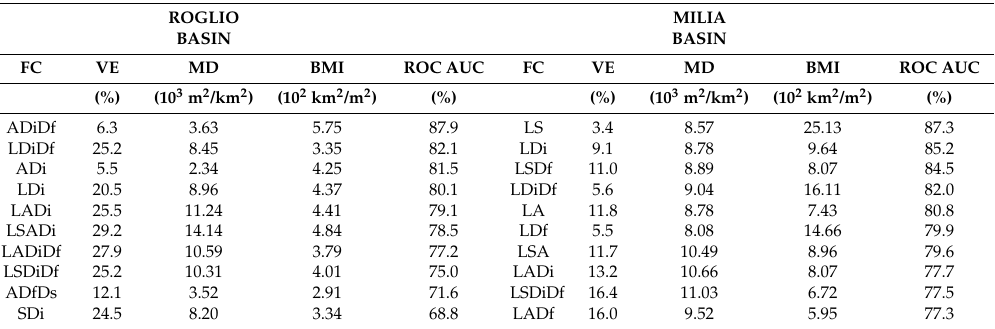
Table 2. The 10 best models of landslide susceptibility obtained for each basin. FC: Factors combination (L: Lithology, S: Slope angle, A: Slope aspect, Di: Distance to hydrographic elements, Df: Distance to tectonic lineaments, Ds: Distance to degradation scarps); VE: Validation error (%); MD: Curve; ROC: receiver operating characteristic curve.